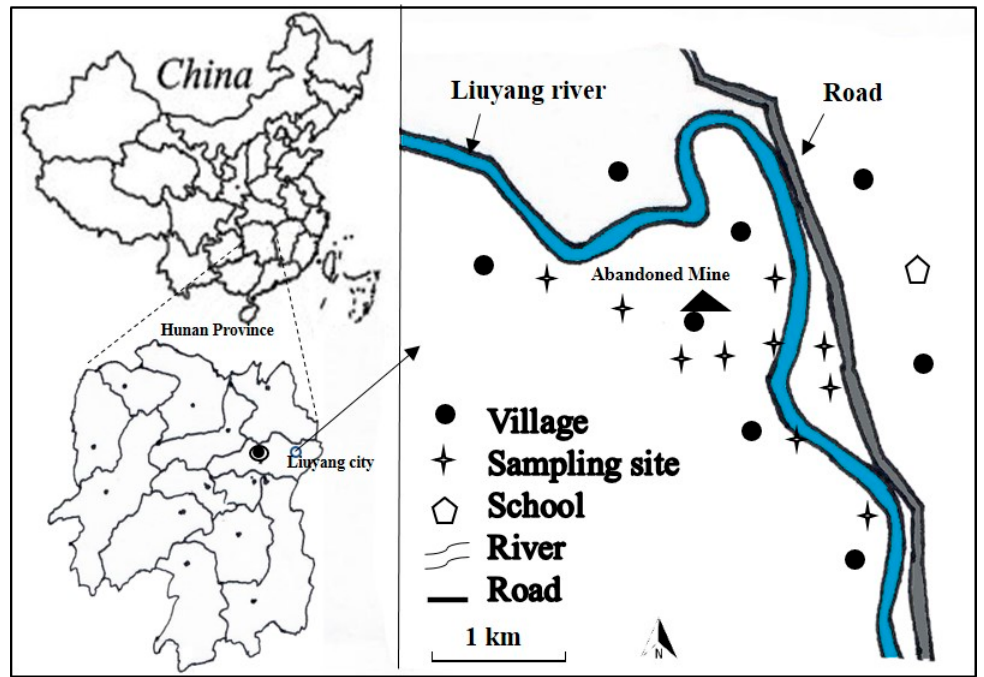
Figure 1. Locations of the study site.